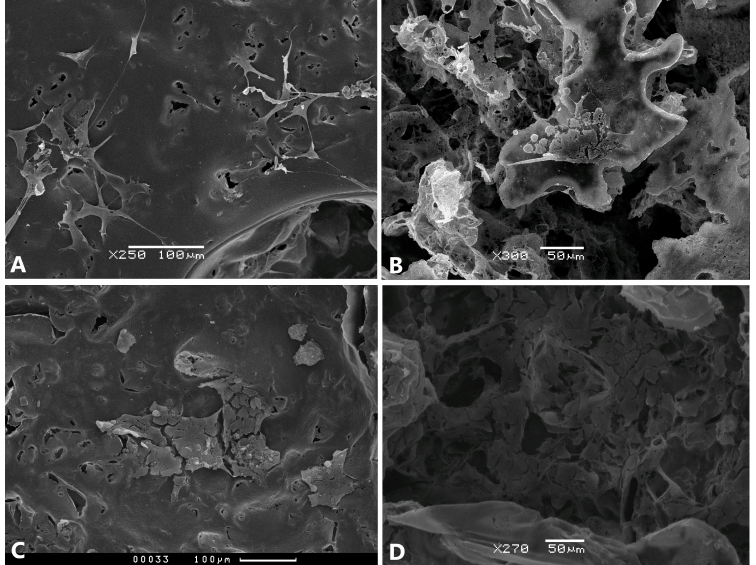
Figure 4. The SEM images of cell attachment and growth on scaffolds. ( A ) MSCs on scaffold-1s; ( B ) and MSCs on scaffold-2s; ( C ) 3T3 fibroblasts on scaffold-1s; ( D ) 3T3 fibroblasts on scaffold-2s. × 250–300. Original microphotographs ( A – D ) in good resolution are presented in Supplemental images for Figure 4. Histological evaluation of tissue reaction to PHB films as Control is presented in Supplemental Materials, Figure